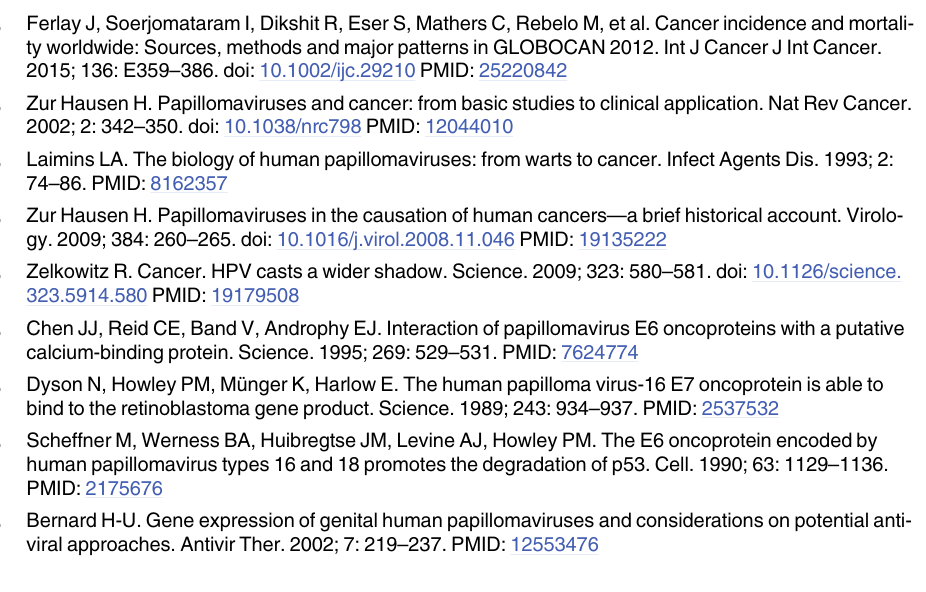
S1 Table. Name and sequence of dsRNAs and ODNs used in this study. All the dsRNA have a TT overhang at the 3' end. S2 Table. List of primers and oligonucleotides used. Name and sequence of the primers used in PCR and RT-PCR in this study. S3 Table. Primers used for Bisulphite sequencing. Name and sequence of primers used in Bisulphite sequencing